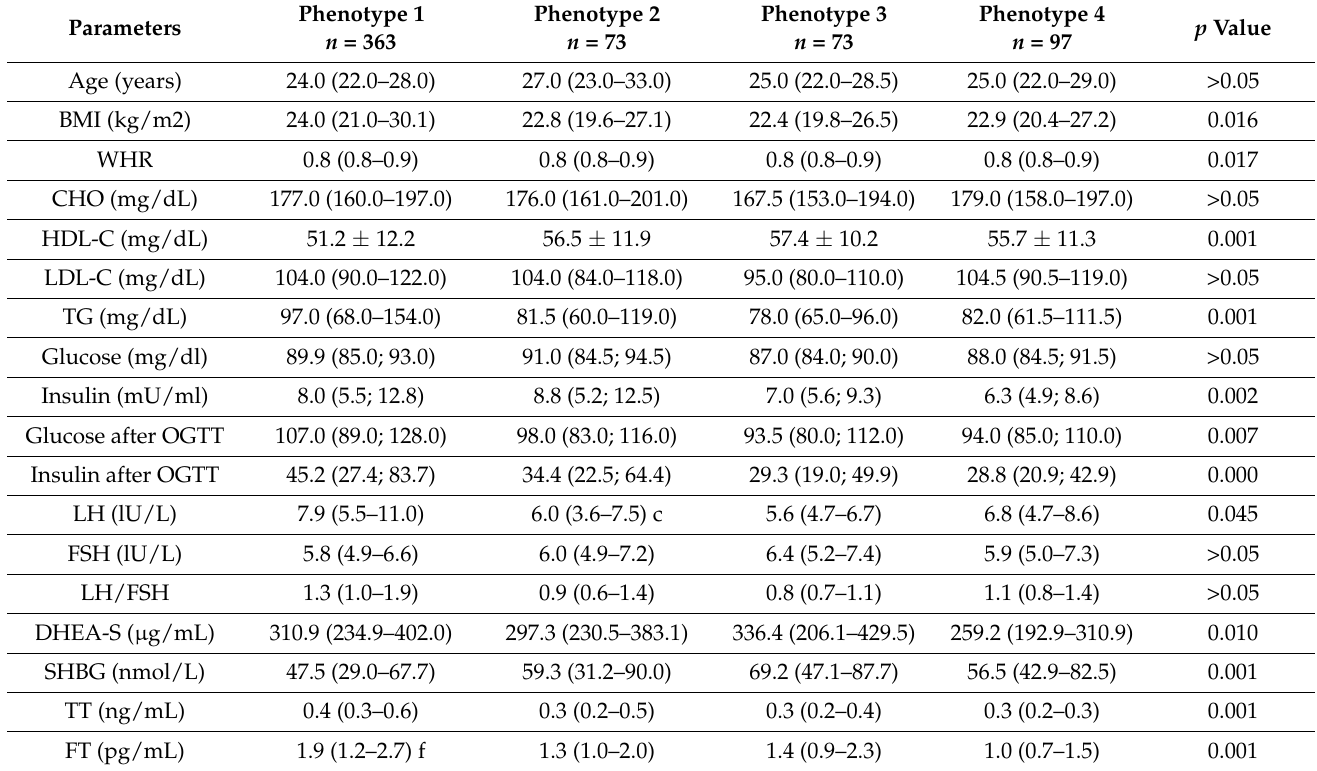
Table 1. Investigated parameters in the subgroups divided according to phenotypes of